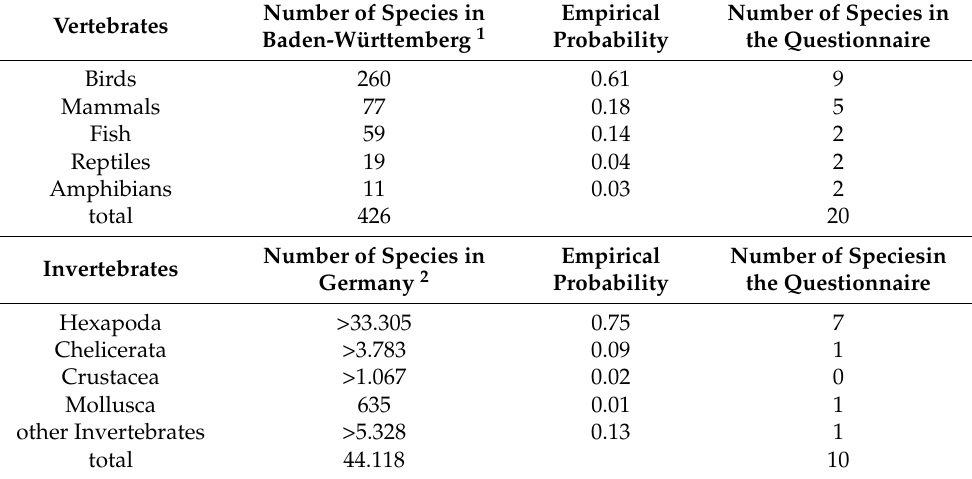
Table 2. Species numbers of vertebrates and invertebrates in Baden-Württemberg and Germany. The empirical probability of the vertebrate/invertebrate classes in BW/Germany as well as their number in the questionnaire is also given. Number of Species in Vertebrates